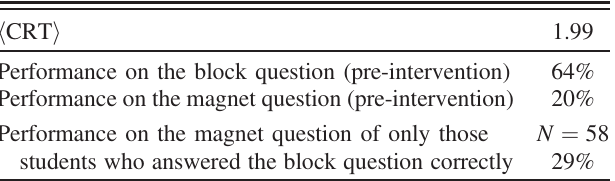
TABLE I. Average CRT scores and performance results from the block and magnet questions administered before the inter- vention ( N ¼ 91 ).